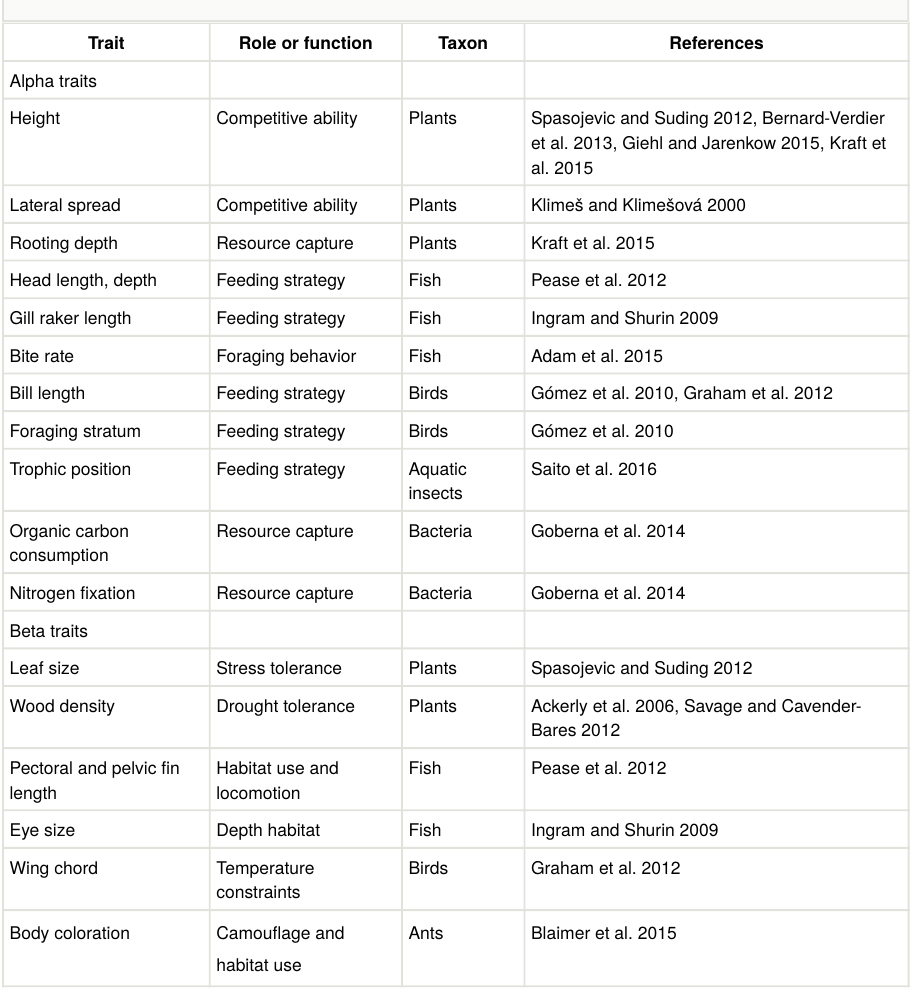
Examples of alpha (competition) and beta (environmental fi ltering) traits from the